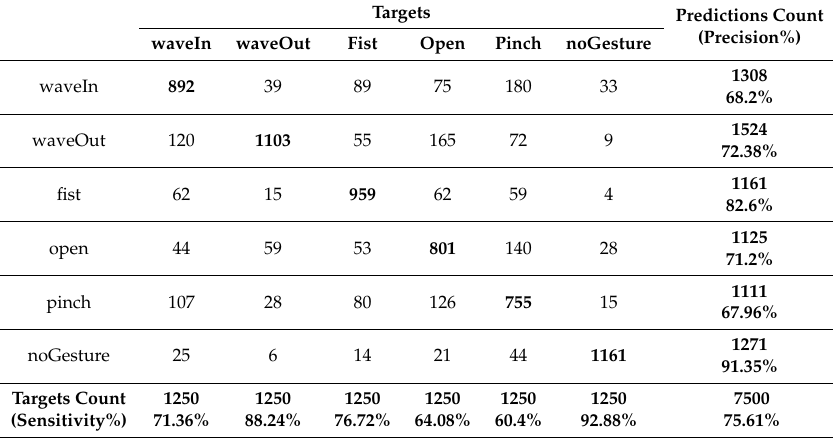
Table A2. Confusion matrix of waveOut sync gesture for the user-general HGR.